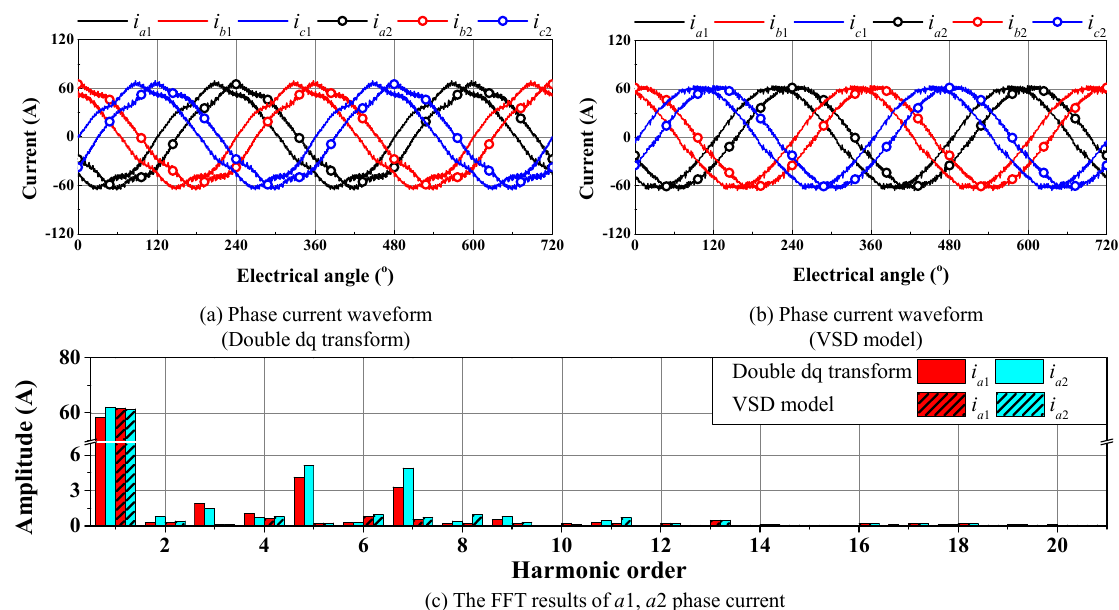
Figure 5. Simulation results of phase current waveform ( a , b ), and FFT analysis ( c ) when applying to the Double dq transform and VSD model.